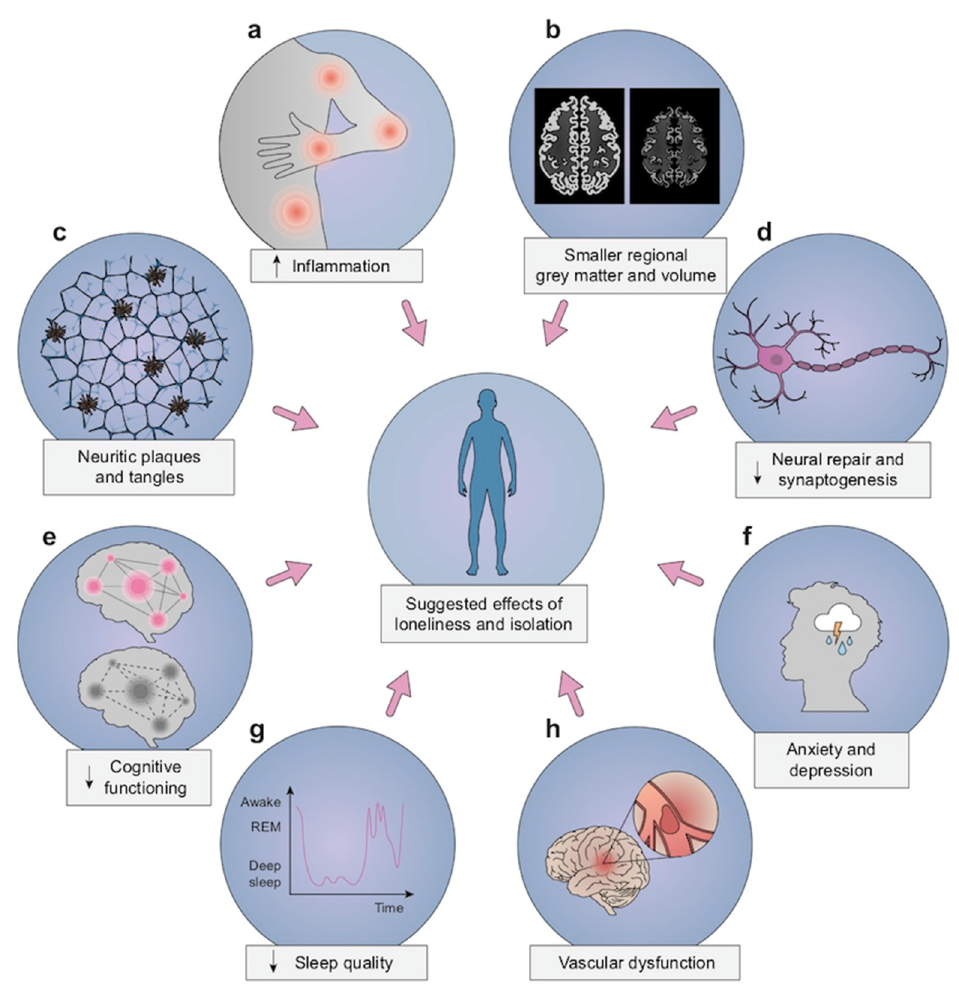
Figure 2. SIL has been related with ( a ) stress-dependent physiological disorders, chronic inflammation, and increased circulating markers for inflammation, ( b ) cortical atrophy and smaller regional brain volumes, including areas that support memory, ( c ) Alzheimer’s disease-related neuropathologic findings, such as amyloid plaques and neurofibrillary tangles, ( d ) decreased neurogenesis and lower levels of brain-derived neurotrophic factor, ( e ) increased risk of all-cause dementia and decreased levels of cognition function in executive function and memory domains, ( f ) poor mental health with increased symptoms of anxiety and depression, ( g ) worse sleep quality, especially sleep fragmentation, and ( h ) increased risk of cerebrovascular dysfunction and impaired post-stroke recovery.